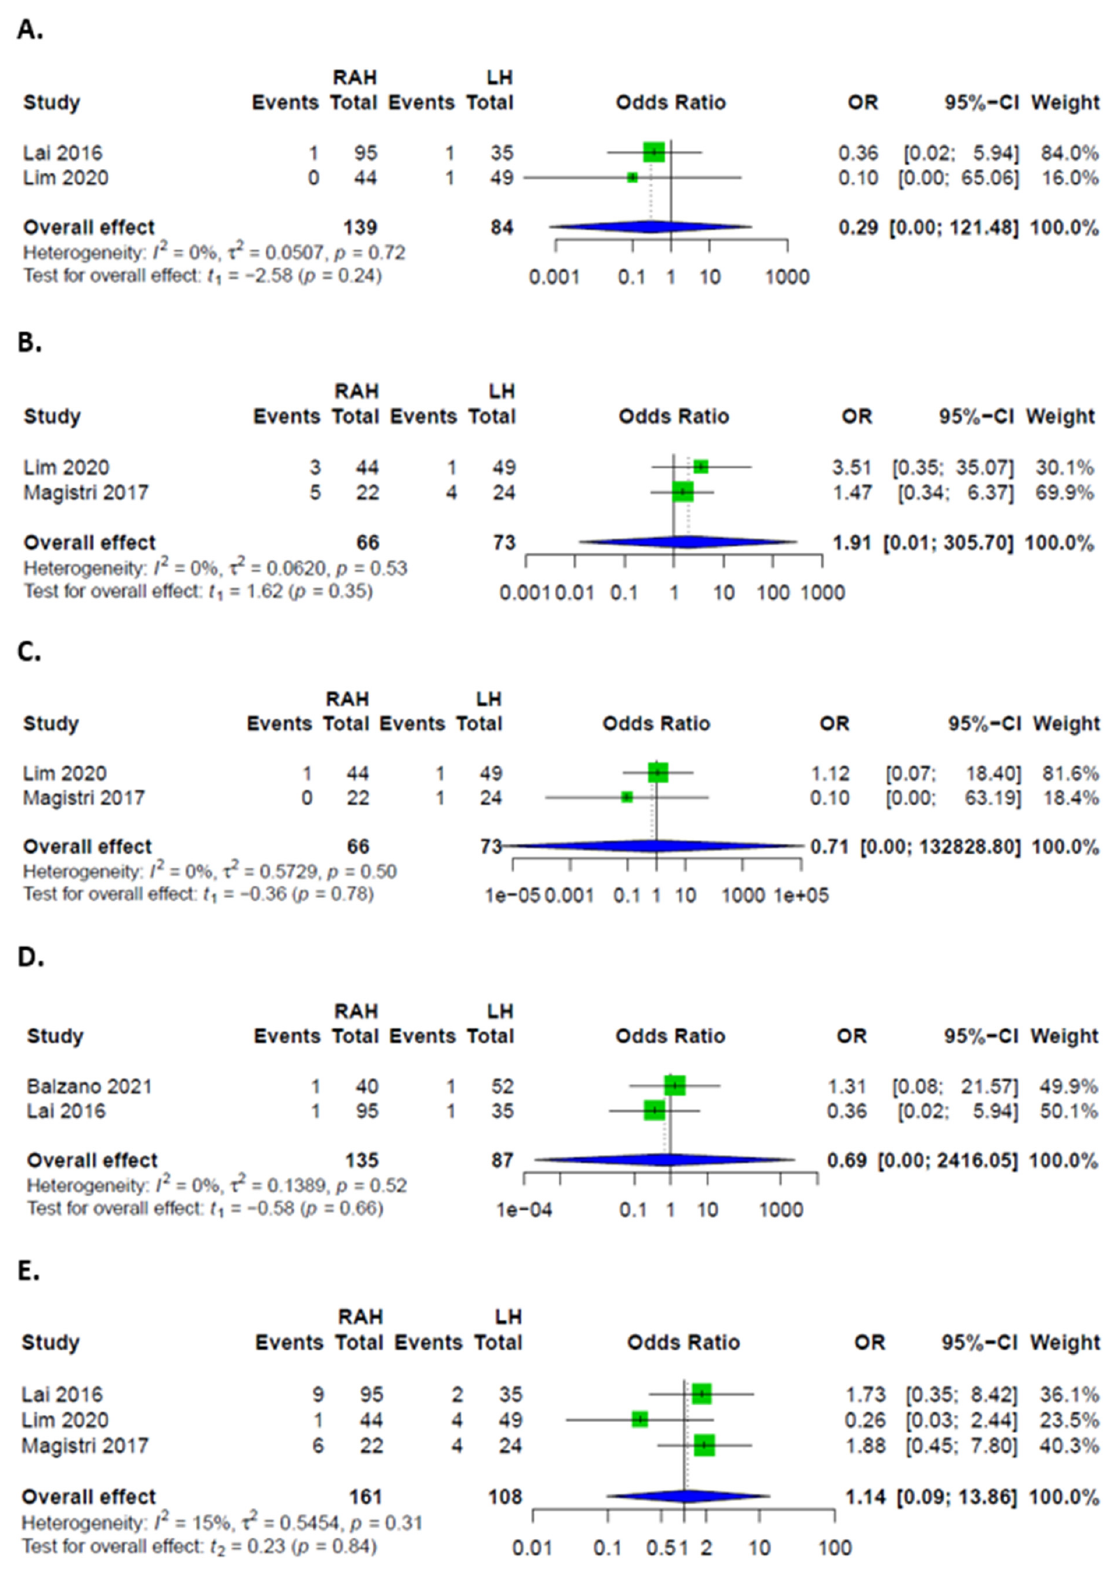
Figure 4. Forest plots for specific complications. ( A ) PHLF in patients after RAH and LH. ( B ) Postoperative ascites in patients after RAH and LH. ( C ) Postoperative biliary leakages in patients after RAH and LH. ( D ) Postoperative hemorrhages in patients after RAH and LH. ( E ) Postoperative infections in patients after RAH and LH.